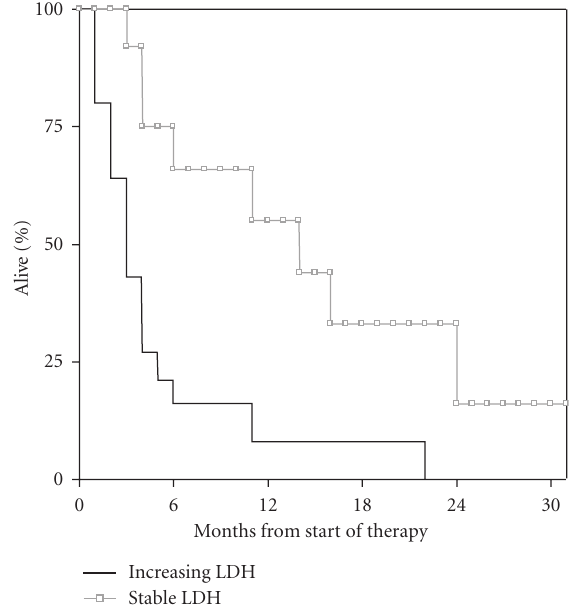
Figure 4: Kaplan-Meier curves for overall survival: LDH increase ≥ 10% within 2 months ( n = 20) versus no such increase ( n = 13); P = 0 .